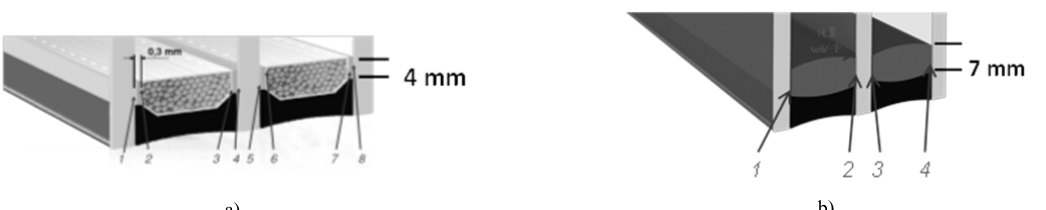
Fig. 27 Number of boundary layers and diffusion/permeation pathways a) conventional b) Ködispace